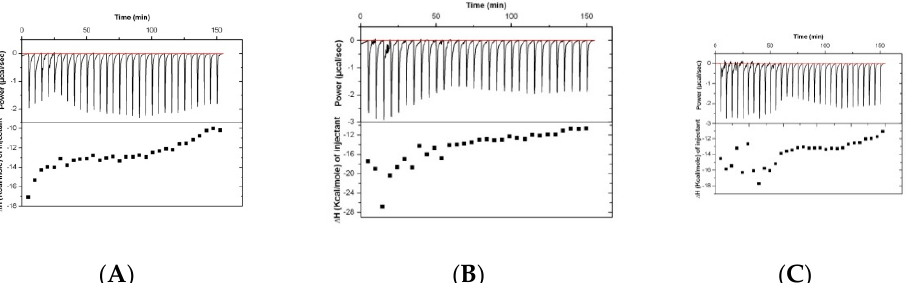
Figure 2. Isothermal titration (ITC) experiments performed by titrating the possibly immunized rabbit serum with Pep19-2.5. The data for three different batches ( A – C ) are characteristic only for a relatively unspecific interaction.